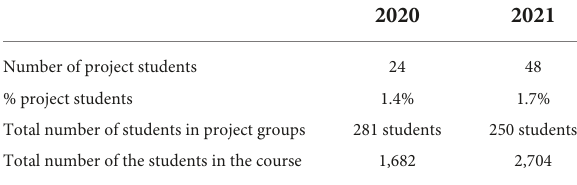
TABLE 1 Participation rate in the applied project in 2020 and